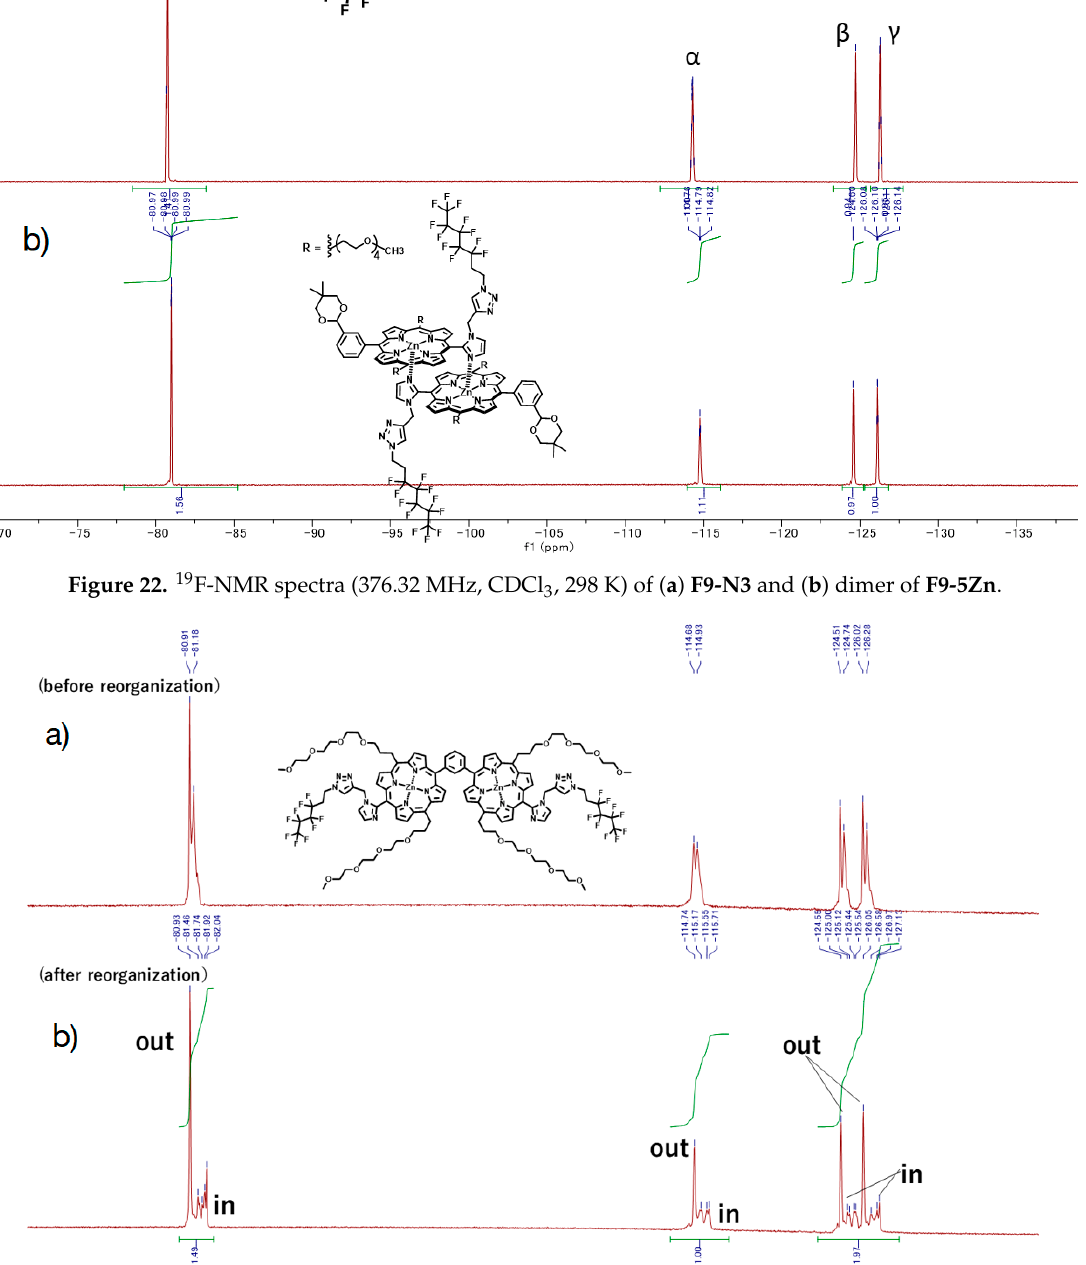
Figure 24. 19 F-NMR spectra (376.32 MHz, CDCl 3 , 298 K) of ( a ) reorganized sample of F9-GP1 , and ( b ) reconstituted sample composed of F9-GP1 and PEG8-GP1 (1:1). 3. Materials and Methods General Procedure. All chemicals and solvents were of commercial reagent quality and used without further purification unless otherwise stated. 3-(4,4-Dimethyl-2,6-dioxan-1-yl)benzaldehyde